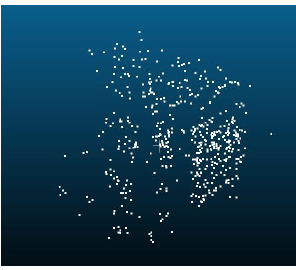
Figure 6. The checker board technique for camera calibration